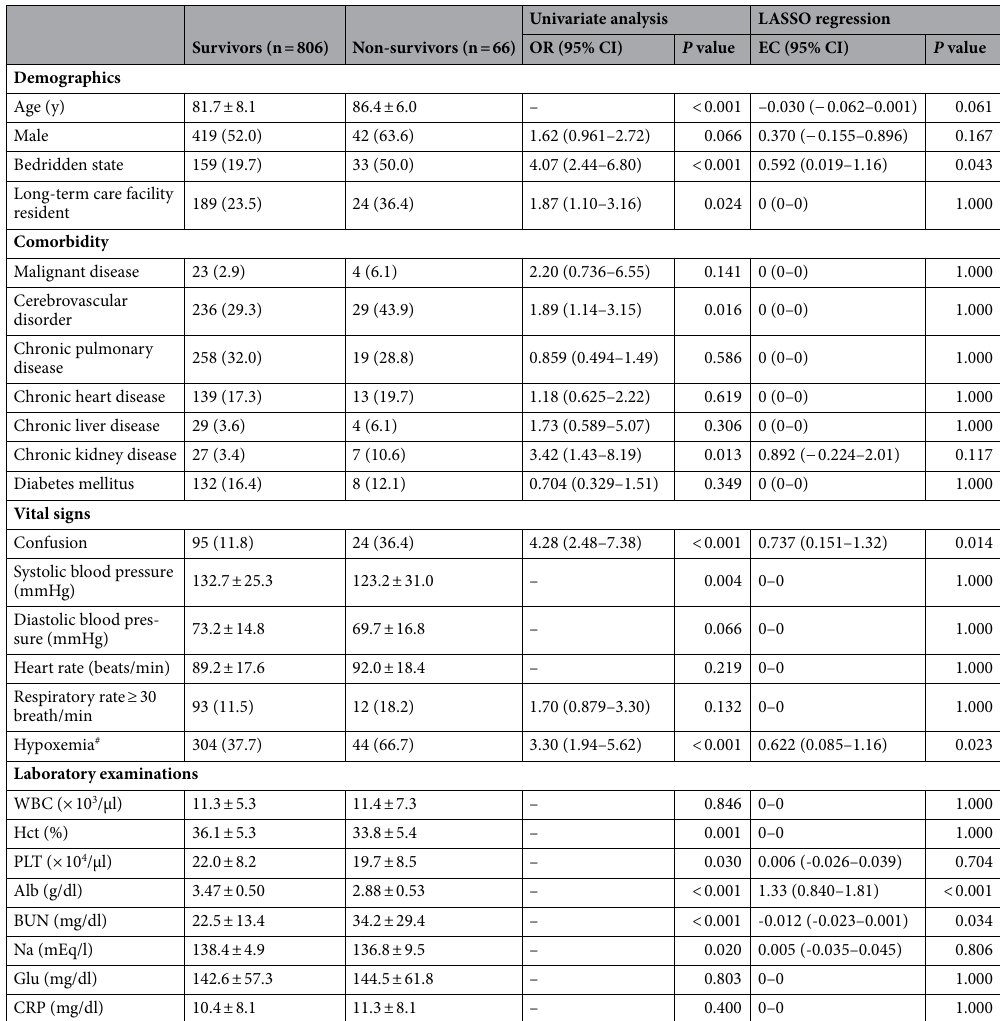
Table 2. Univariate analysis and LASSO regression of prognostic factors associated with 30-day mortality. Data are presented as mean ± standard deviation or n (%). # Hypoxemia: SpO 2 ≤ 90% or PaO 2 ≤ 60 mmHg. OR, odds ratio; CI, confidence interval; EC, estimated coefficients; WBC, white blood count; Hct, hematocrit; PLT, platelet; Alb, albumin; BUN, blood urea nitrogen; Na, sodium; Glu, glucose; CRP, C-reactive protein.